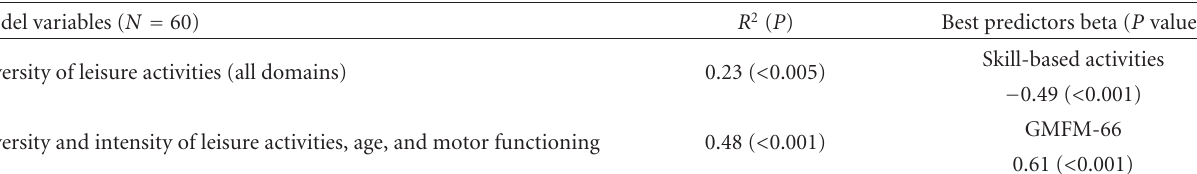
Table 4: Best predictive models of physical well-being